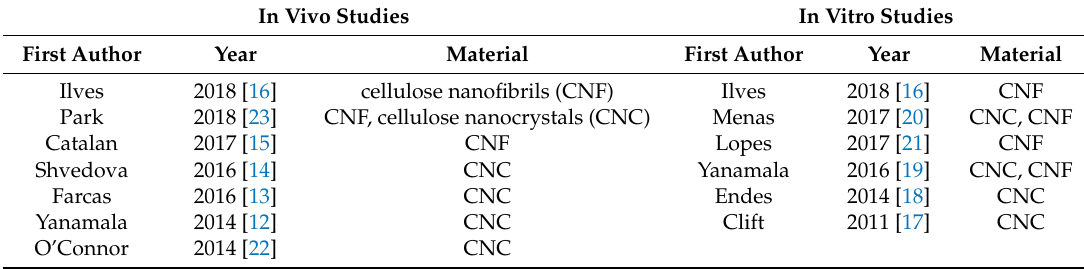
Table 1. Published studies examining effects of cellulose nanomaterial (CN) inhalation. In Vivo Studies In Vitro